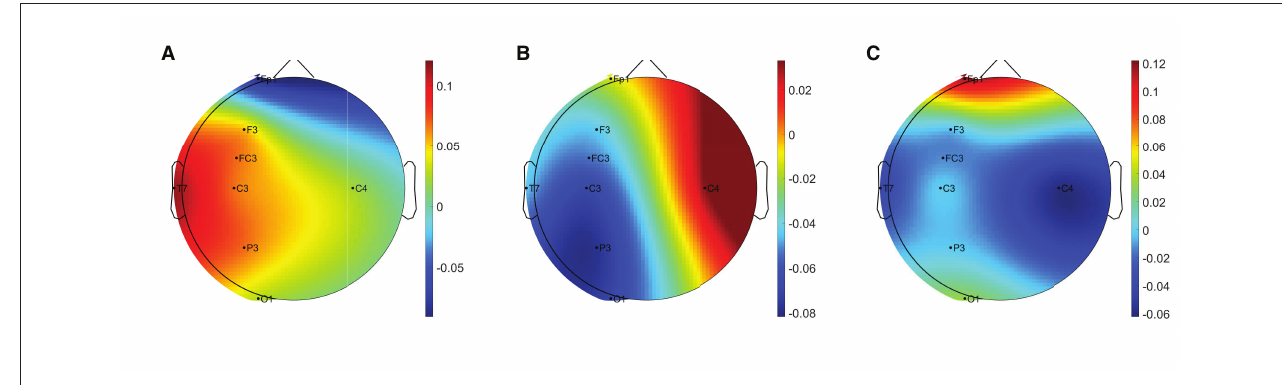
FIGURE 9 | Brain topographies for the difference between recovery and baseline states (i.e., difference = recovery - baseline) of (A) δ relative , (B) θ relative , and (C) α relative for one participant following the fine motor interaction with SCRIPT passive orthosis. In each brain map, the nose is represented by the triangle on the top, and the right hemisphere is on the right. The red-shaded areas indicate a larger increase whereas the blue-shaded areas indicate a larger decrease.